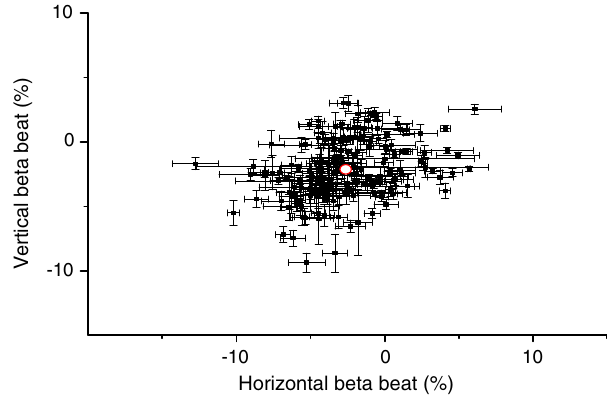
FIG. 1. Residual beta-beat after optics correction with QV. The rms value of the residual beta-beat is 4.0% and 3.2% in the horizontal and vertical planes, respectively. The average beta- beat, indicated by the open (red) circle, is offset by (cid:1) 2 : 6% and (cid:1) 2 : 1% in the horizontal and vertical planes, respectively.